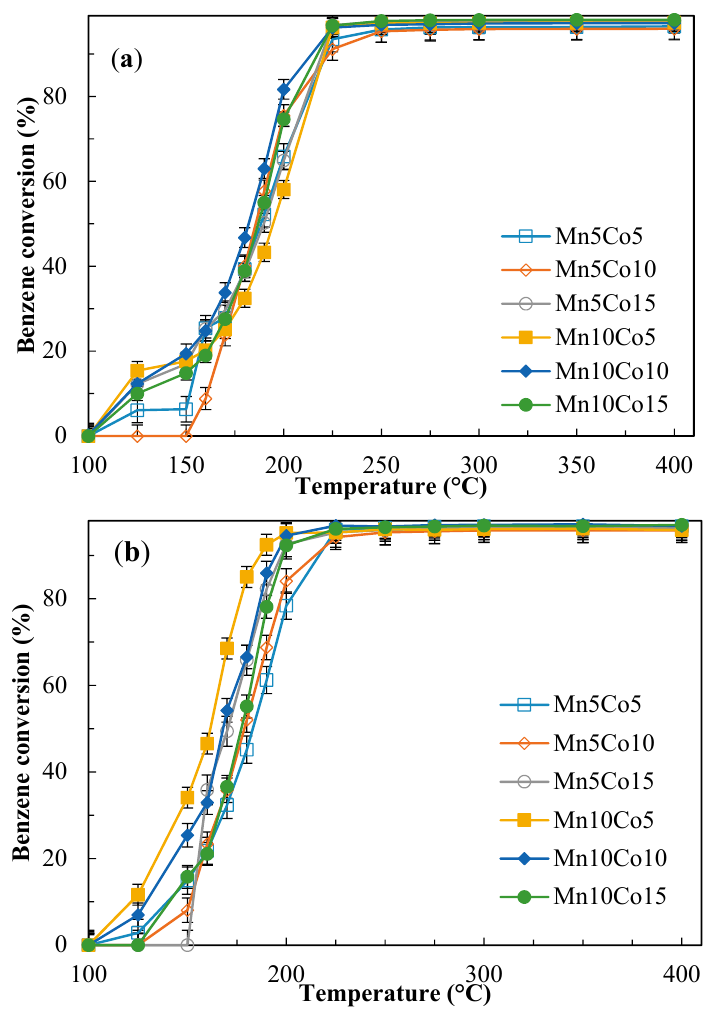
Figure 6. Average conversion rates of benzene estimated over three runs on ( a ) Mn x Co y /N and ( b ) Mn x Co y /F during the light-off experiments. Table 3. Conversion rates of benzene and yields of CO 2 at reaction temperatures of 190 °C and 225 °C.